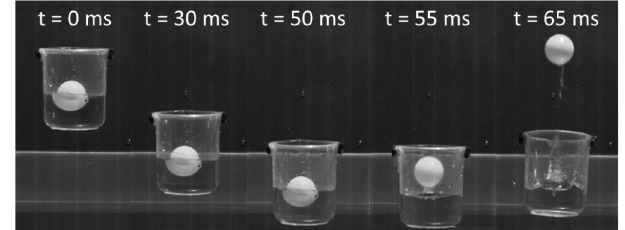
Fig. 1. Snapshots from a high-speed video of dynamics of a ping- pong ball placed in a water-filled beaker falling to the ground. During the free fall, the ball is sucked into the water by capillary forces. Upon collision, the ball is ejected at large velocity by the strongly enhanced Archimedes’ force.